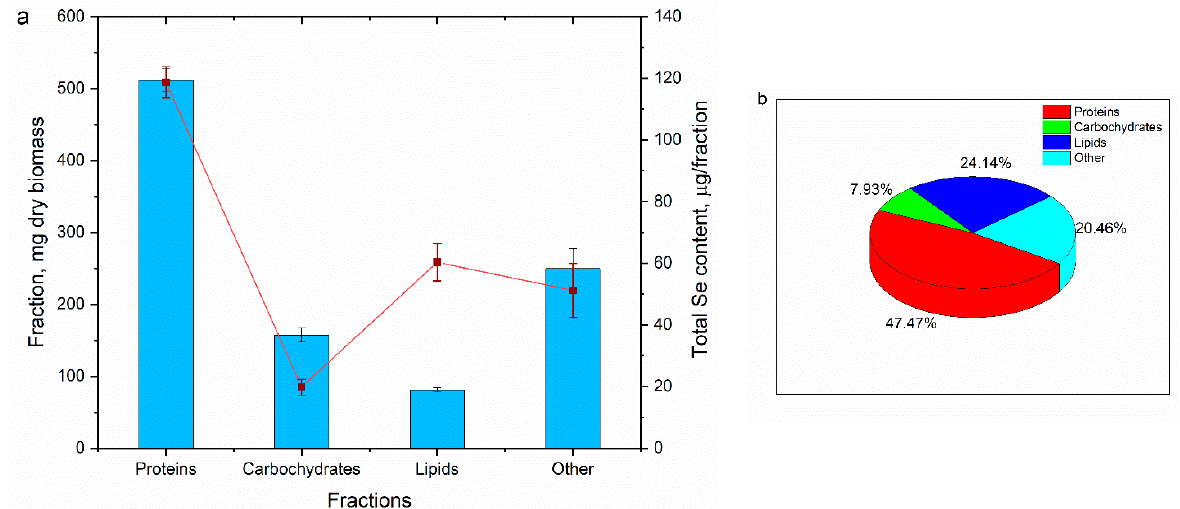
Figure 2. Amount of Se accumulated in biomass fractions: ( a ) total content of Se, µg Se/g per fraction; ( b ) distribution of Se accumulated by fractions, % of the accumulated amount (n = 3, the error bars represent the standard deviation of the measurements) .